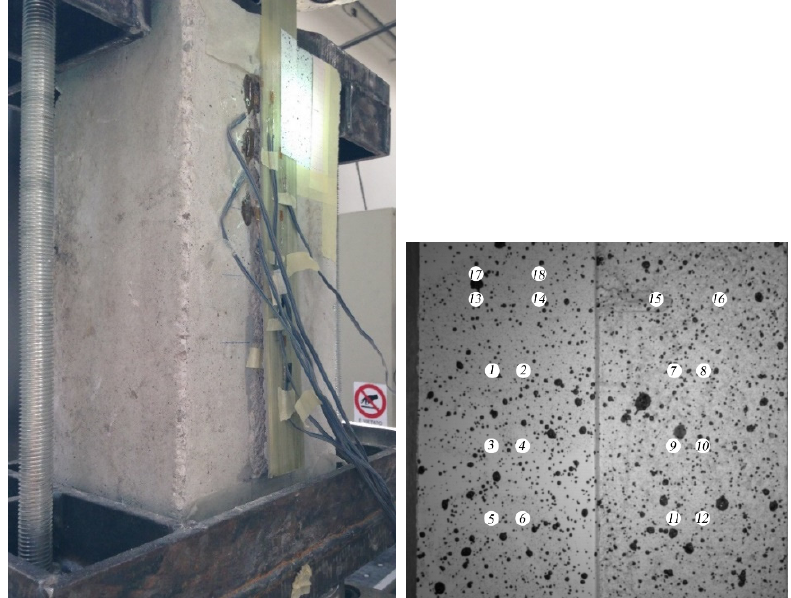
Figure 7. Experimental bond test ( left ), Region of Interest placed on the composite ( right ) [25].